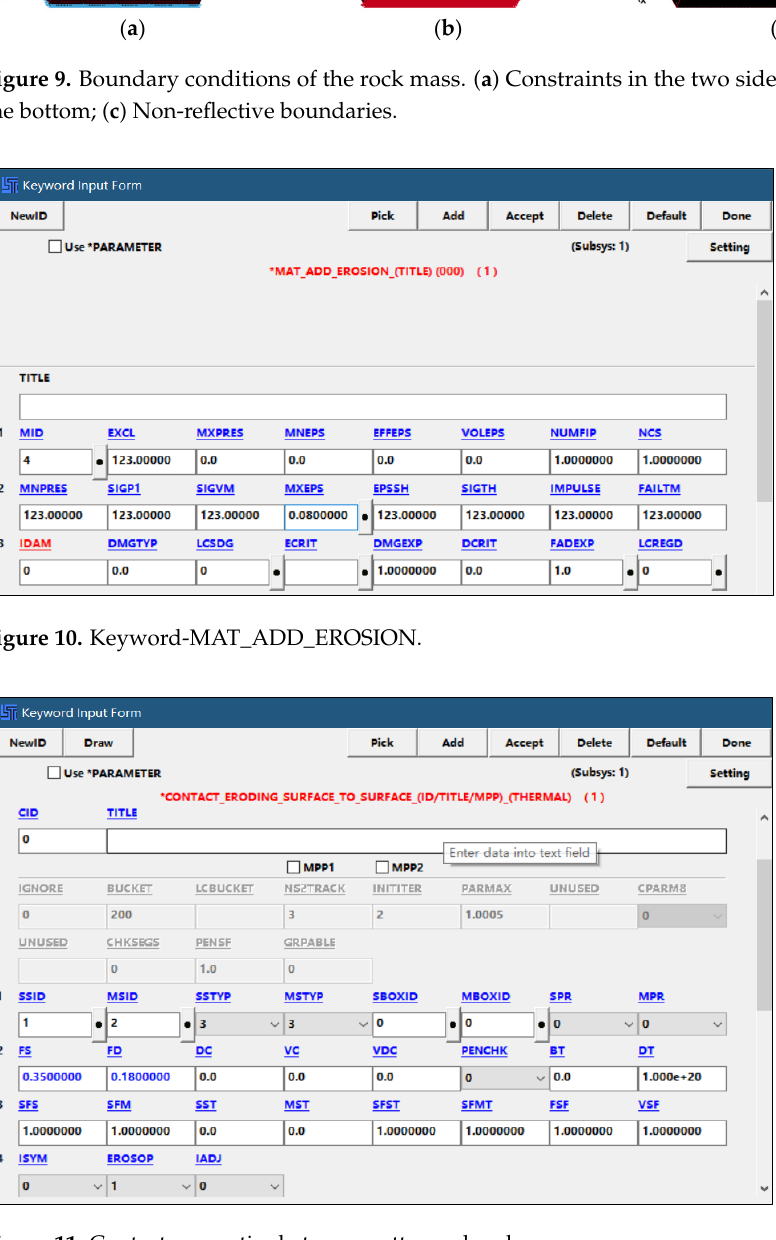
Figure 11. Contact properties between cutter and rock.